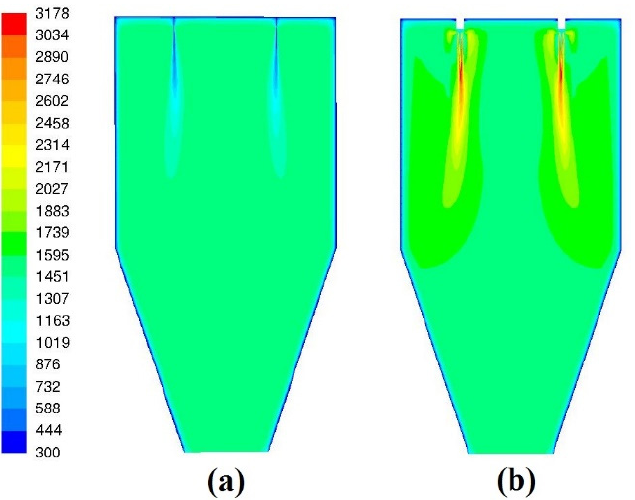
Figure 20. Velocity vector field in the plane passing through ( a ) the centers of two opposite burn- ers and ( b ) the centers of two opposite powder feeder ports (unit in m/s). and ( b ) the centers of two opposite powder feeder ports (unit in m/s).